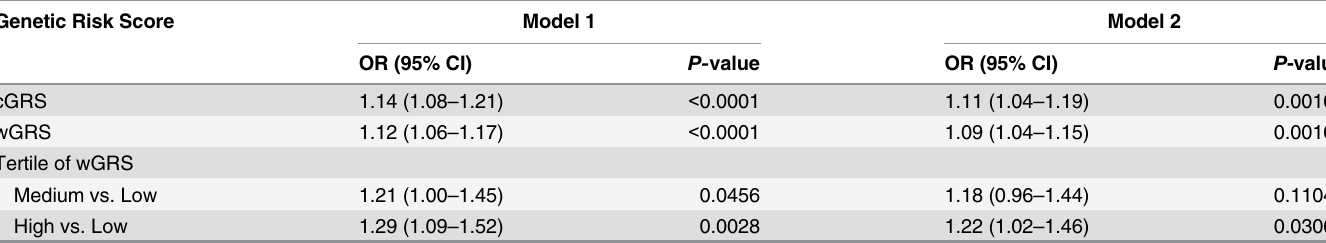
Table 5. Multiple adjusted hazard ratios for hypertension incidence after 4-year follow-up.